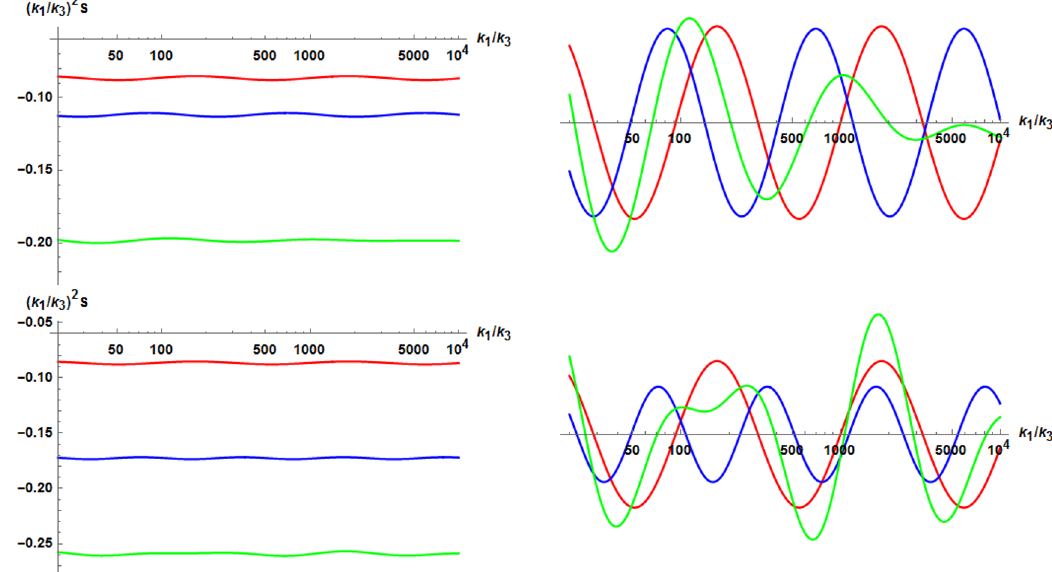
Figure 3 . The same figure with figure 2 in the case with non-universal coupling constants. The masses and the couplings are set as ( m panel. Those of the lower one are ( m